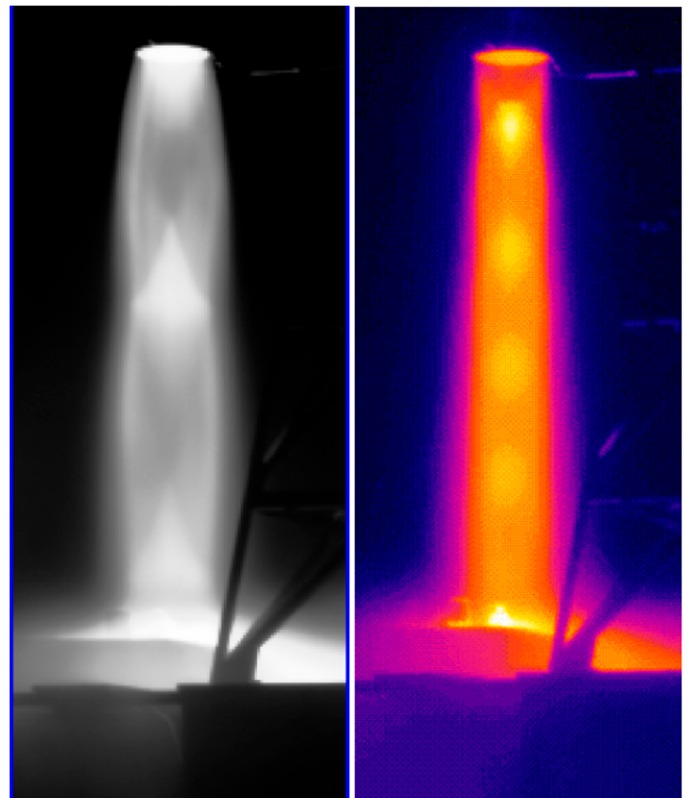
Figure 9. Infrared images were obtained with SC655 IR Camera taken during an Ares I test in the lift-off condition. Reprinted with permission from Ref. [30] (2011). lift-off condition. Reprinted with permission from Ref. [30]